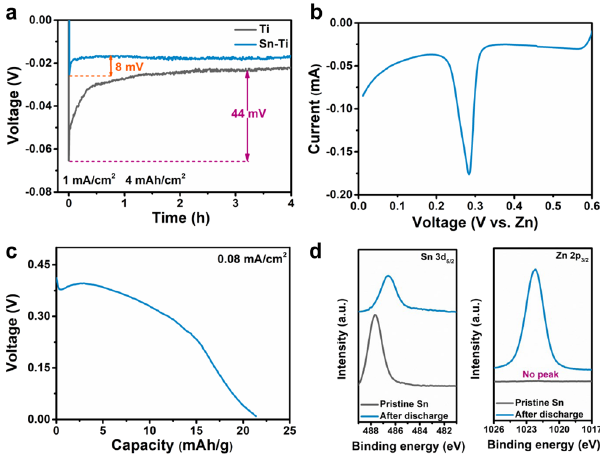
Fig. 2 The alloy reaction between Sn and Zn. a The nucleation overpotential of Zn on Ti and Sn-Ti current collectors; b CV of Sn-Ti/Zn cell at a scan rate of 0.2 mV/s; c the galvanostatic discharge curve of Sn-Ti/Zn cell at 0.08 mA/cm 2 ; and d XPS spectra of Sn 3 d and Zn 2 p for pristine and discharged